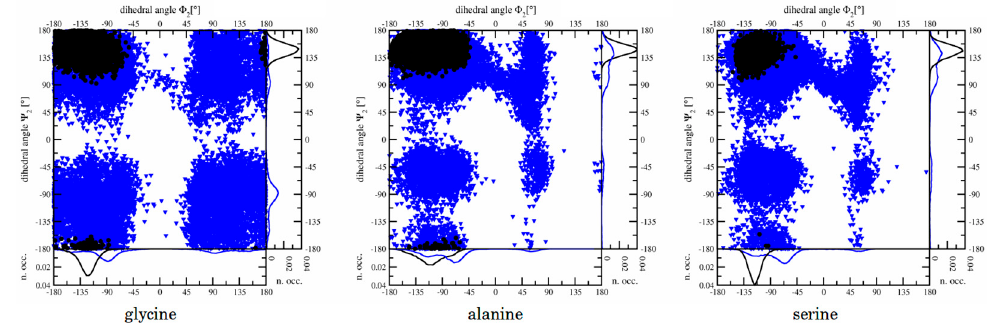
Figure 4. Narrowing of sampled conformational space upon binding, monitored via central side chain dihedral angles. Blue triangles: free in solvent; black circles: complexed in OppA. Data was extracted from the longest available simulation of the end state at λ = 0, ( i.e. , the crystal structure before alchemical changes): All φ 2 / ψ 2 side chain dihedral angles are monitored over 10 ns simulation time, except for KSK complexed in OppA (right panel, black circles), for which only 3 ns simulation time was available. Distributions are summed up for each angle in the flanking graphs on the right and below each Ramachandran plot, and the number of occurrences (n.occ.) was normalized.